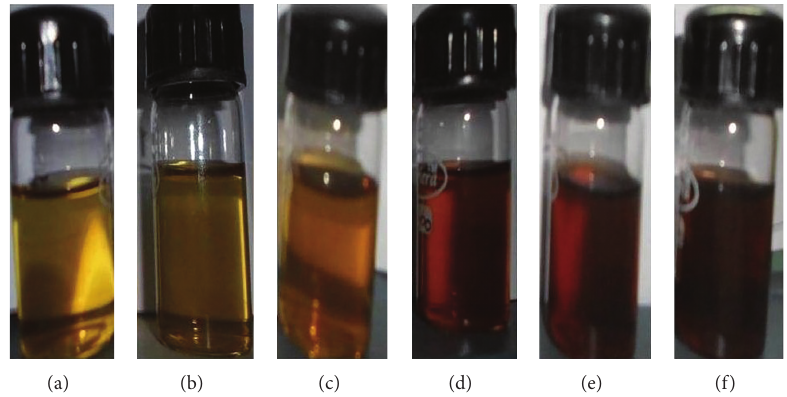
Figure 1: Visual identification of silver nanoparticles synthesized by M. tinctoria leaf extract at pH 8.6 as recorded at different functional time ((a) initial, (b) 10 min, (c) 30 min, (d) 1h, (e) 2 h, and (f) 4 h). The formation of dark brown colour revealed the formation of silver nanoparticles in the reaction